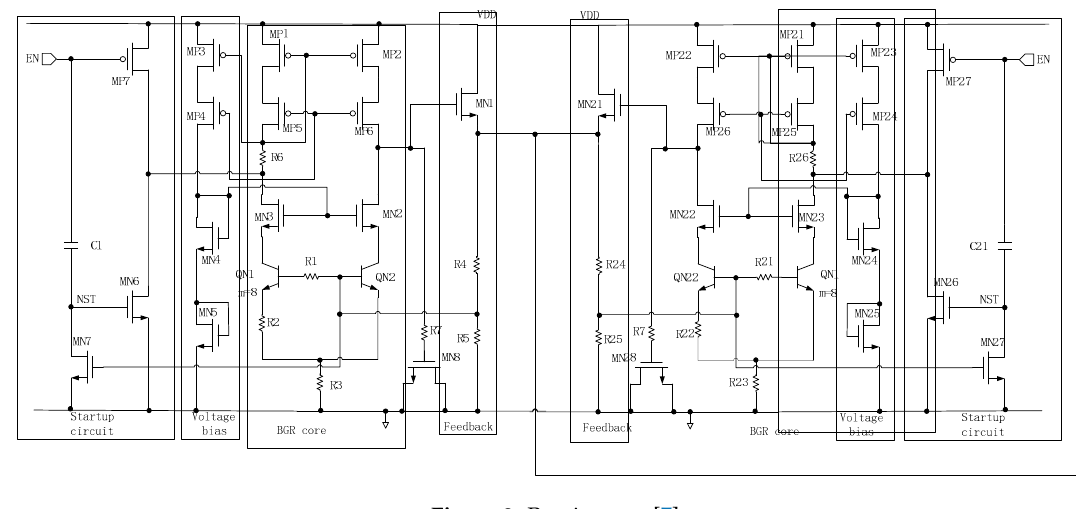
Figure 2. Previous art [7].